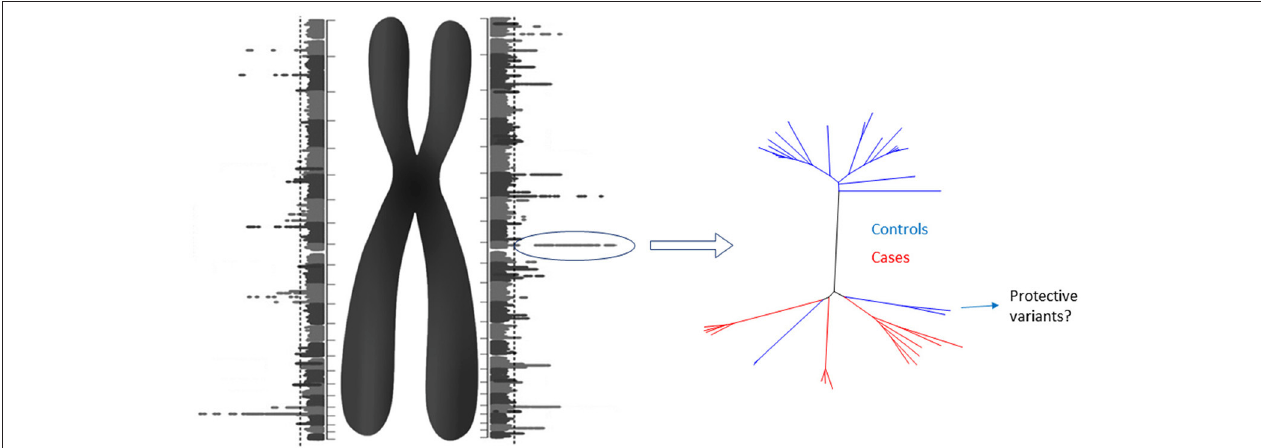
FIGURE 1 | The Diploid Manhattan Plot: To achieve personalized medicine we need to isolate individual diploid genomes and compare them with a reference genome. Each homologous chromosome can be compared with the regular “haploid reference genome.” Thus, two GWAS that include the individual physical context of each genetic variant (including structural variants) will be produced. Since those DNA stretches would have a manageable size, the highest individual hits could be selected for further characterization comparing them with cases and control diploid genomes. For low penetrance diseases, protective SNPs in cis could be found. Diploid genomes have the potential to close the gap of the missing heritability